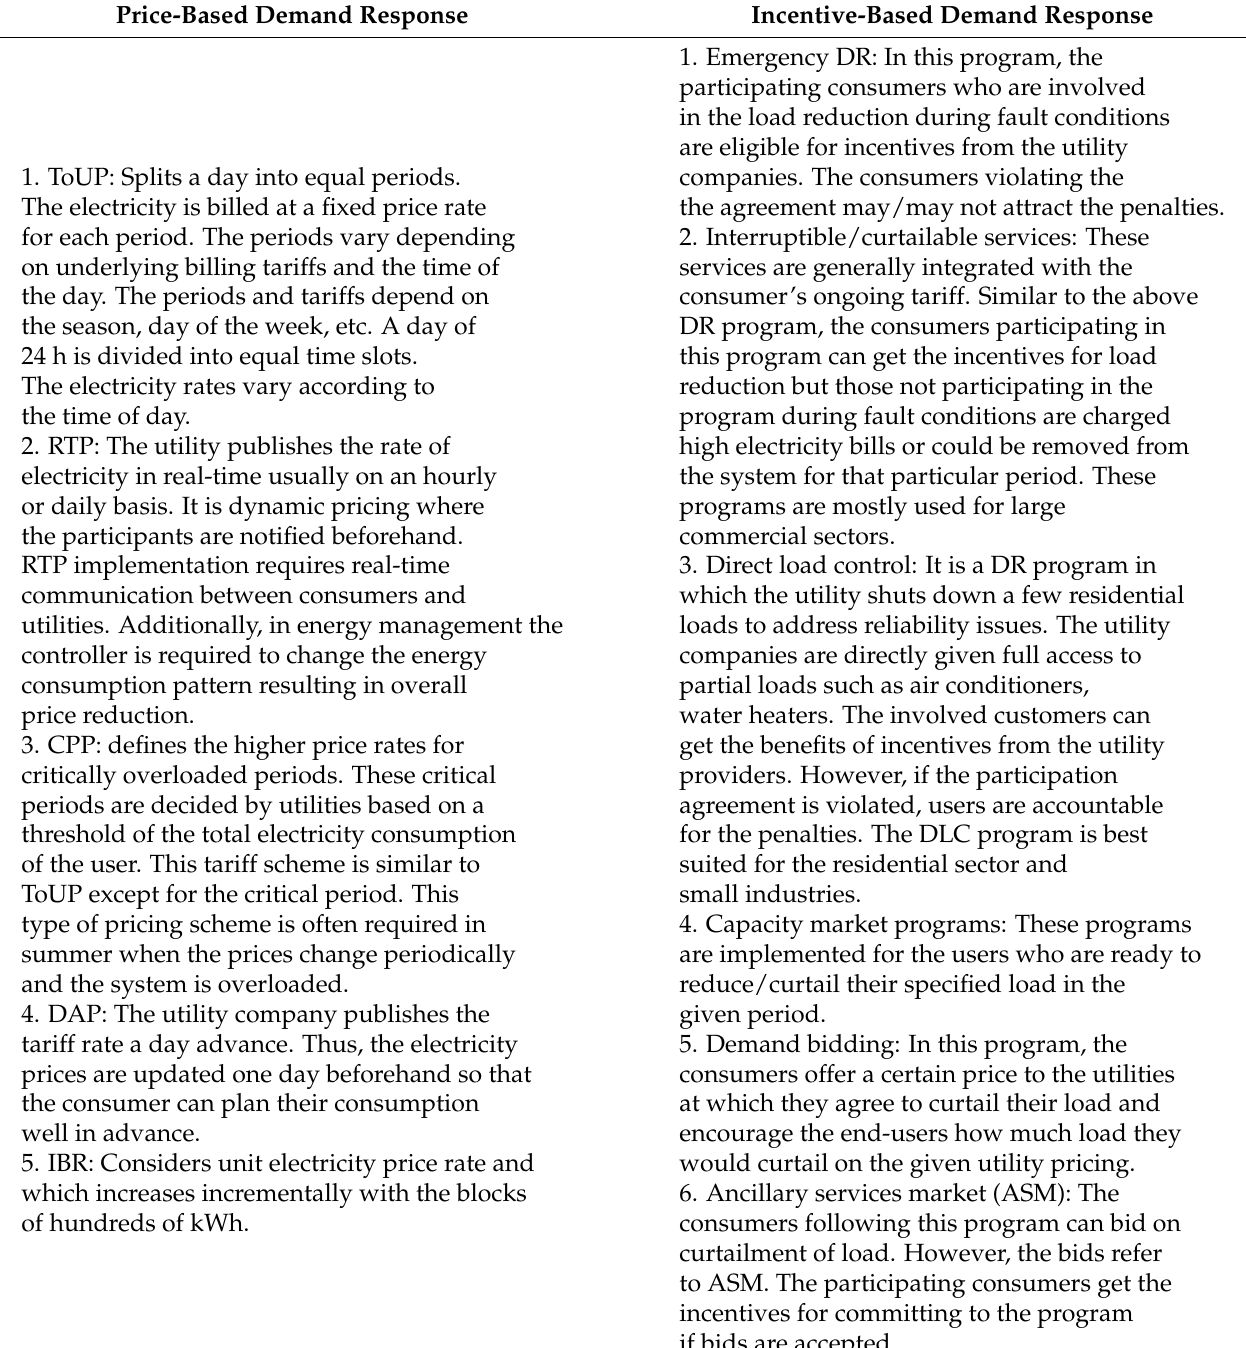
Table 1. Summarized demand response